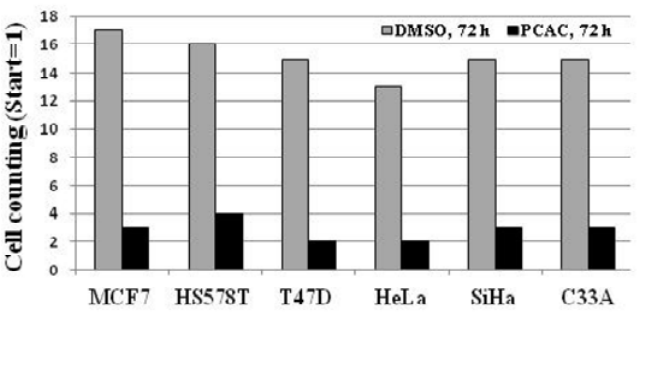
Figure 5. Effect of PCAC on cell proliferation of the six other cancer cell lines